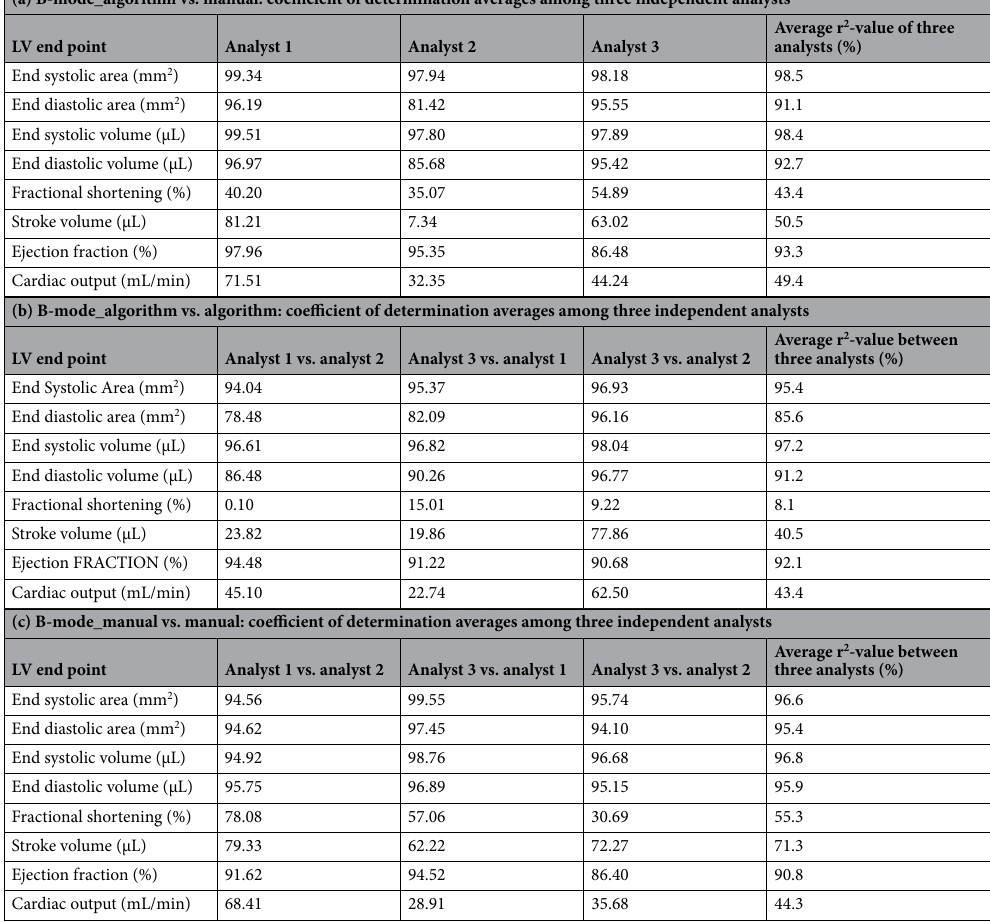
Table 1. Data tables of coefficient of determination averages ( r 2 ) among the three independent analysts for long axis B-mode left ventricle functional and structural end-points. (a) Compares average coefficient of determination for each analyst using the semi-automated segmentation algorithm related to using the manual segmentation technique; (b) compares within analyst coefficient of determination averages while using the semi-automated analysis algorithm; and (c) compares within analyst coefficient of determination averages when using manual segmentation. P-values were set at < 0.05.